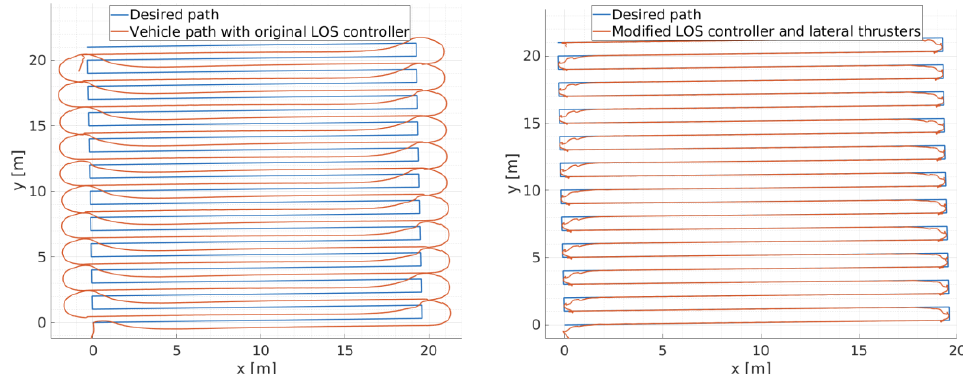
Figure 17. Simulation results for a lawn mower pattern employing the vehicle’s original configuration—SPARUS II ( left ) and the modified configuration—ALICE ( right